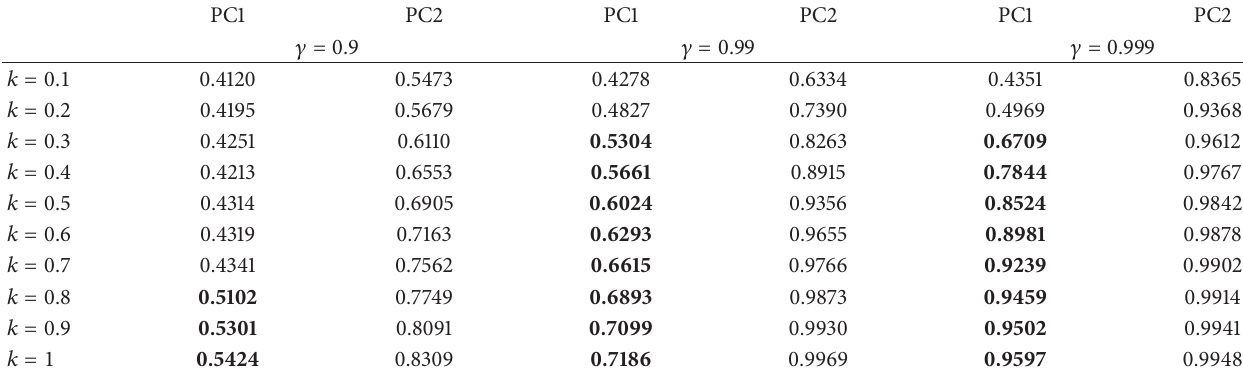
Table 1: The values of 𝐷 for different values of 𝑘 and 𝑤 .